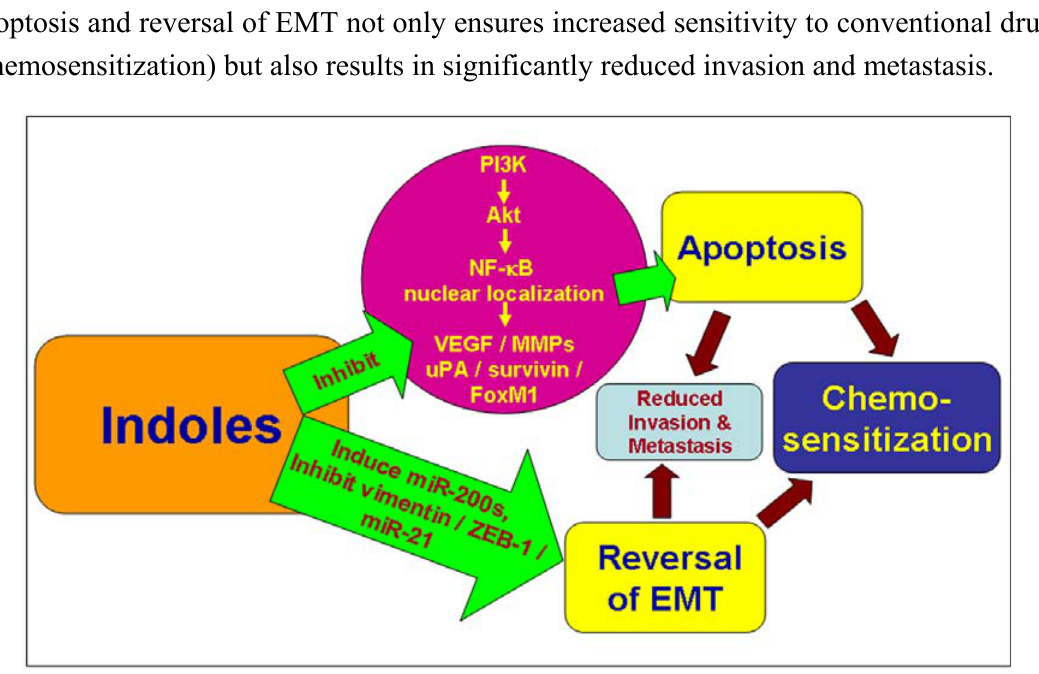
Figure 1. Mechanisms of anticancer and chemosensitizing effects of Indole compounds. Indole compounds, such as I3C and its dimmer DIM, induce apoptosis through